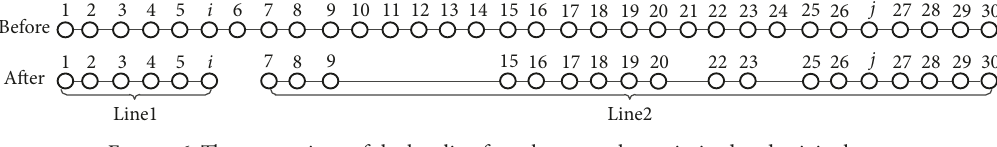
Figure 6: The comparison of the bus line form between the optimized and original one.